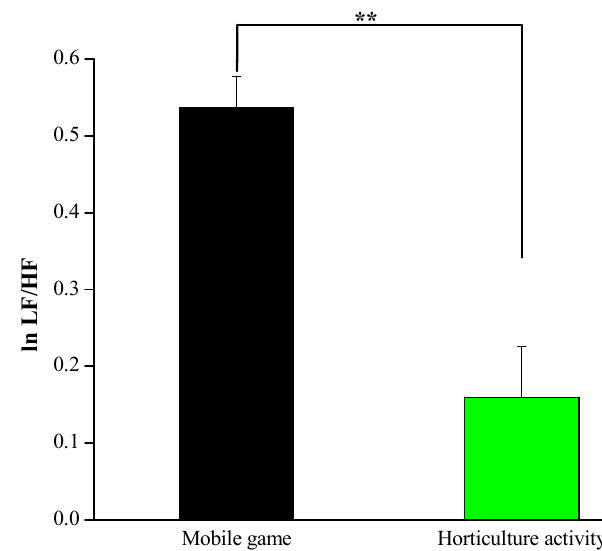
Figure 3. Ratio of low-frequency to high-frequency band (lnLF/HF) during the 5 min experimental period; n = 26, mean ± SE, ** p < 0.01 determined by the paired t -test.